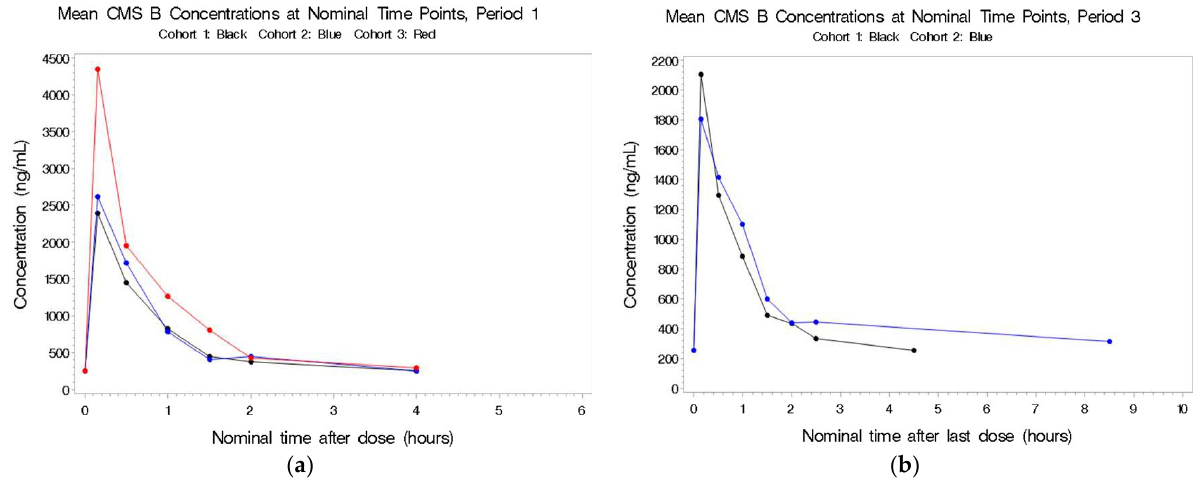
Figure 4. ( a , b ) Mean plasma concentrations for CMS B after last dose in Period 1 by